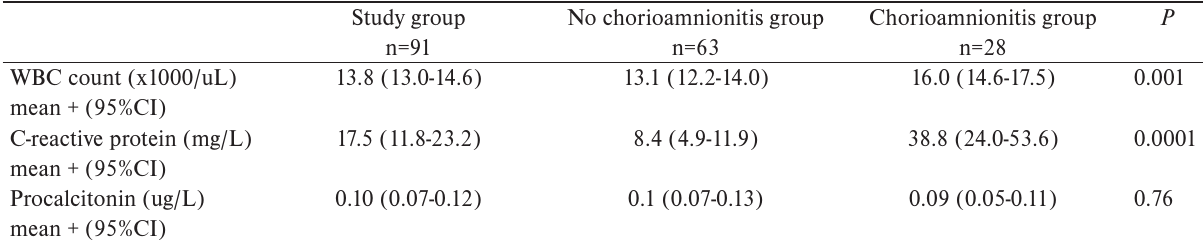
Table 1. Maternal inflammatory parameters in study population and as per study group (no chorioamnionitis versus histologically proven